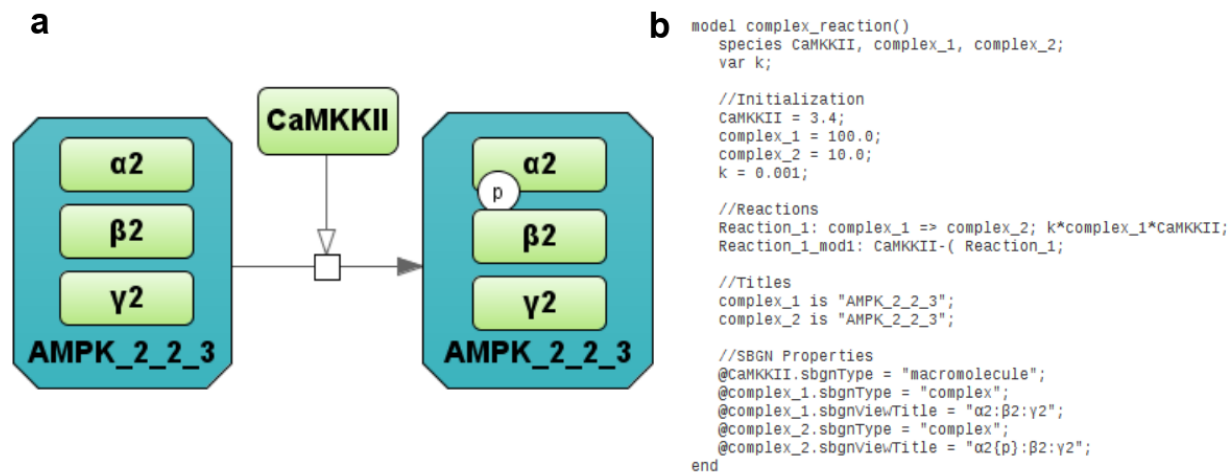
Figure 2. Representation of the simple chemical reaction ( a ) using the SBGN Process Diagram type and Antimony with annotations ( b ). Three green rectangles α 2, β 2, γ 2 inside the dark green octagon AMPK_2_2_3 designate corresponding subunits of the AMPK, while green rectangle CAMKKII mean the kinase catalyzing the phosphorylation reaction.